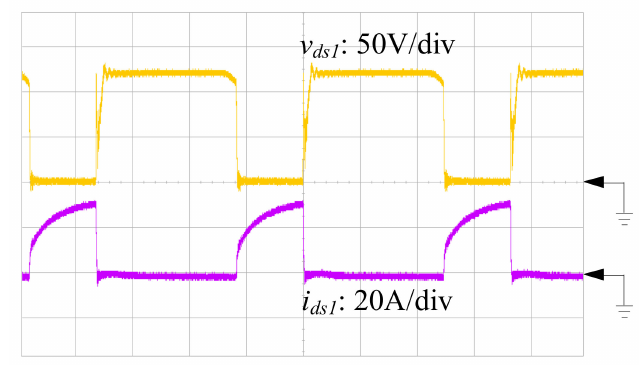
Figure 8. The measured waveforms from active switch S 1 .